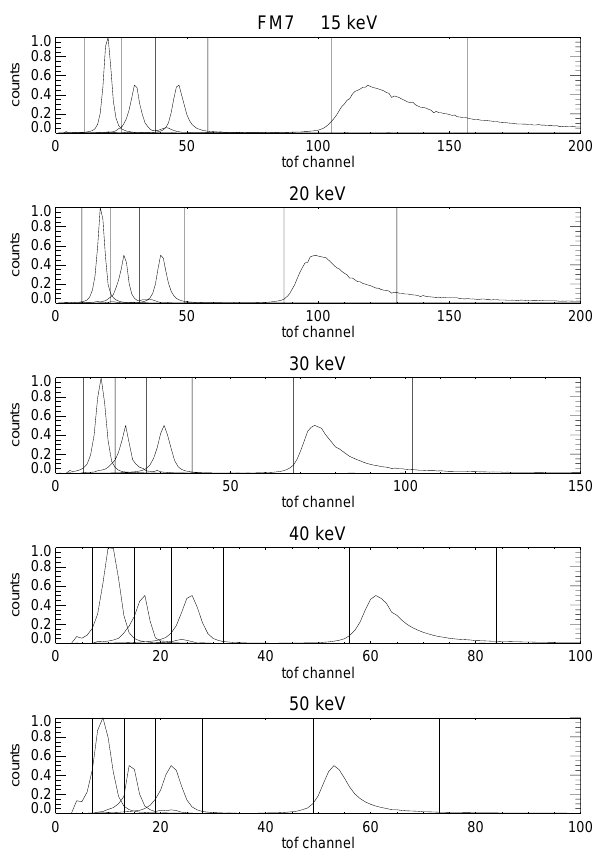
Fig. 16. CODIF FM7 time-of flight spectra for the four major species at 5 energies. The spectra are averaged over all positions. The vertical lines show the thresholds used to distinguish species.